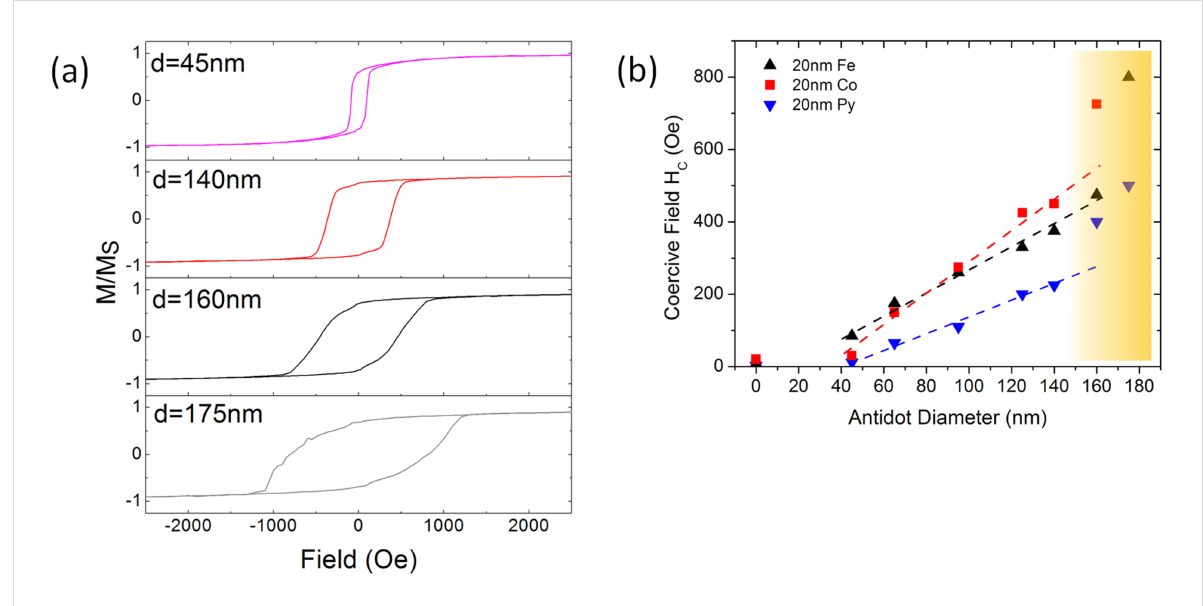
Figure 5: (a) In-plane hysteresis loops of 20 nm thick Fe antidot arrays with constant period of a = 200 nm and varied antidot diameter d measured at T = 300 K. The coercive field rises monotonously with increasing antidot diameter. The hysteresis loops change from a square-like behaviour for smaller antidot diameters d < 150 nm towards a more convex shape with a much wider switching field distribution for larger diameters d > 150 nm. Panel (b) presents the coercive field of Fe, Co, and Py antidot films as function of d . All materials show a linear increase of the coercive field between d = 45 nm and d = 150 nm as indicated by the dashed lines. For larger antidots, the coercive field jumps to significantly larger values as indicated by the orange shaded